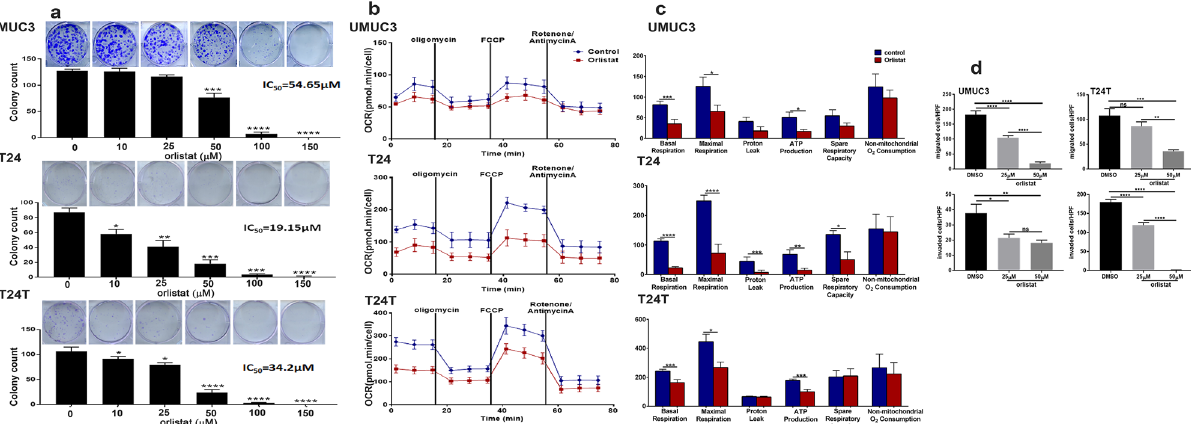
Figure 8. Effect of FASN inhibition by orlistat on BCa cells: ( a ) orlistat exerts dose-dependent inhibition of clonogenic survival of the indicated BCa cell lines. Representative images of colonies > 50 cells after treatment with orlistat. Bar graphs report mean ± SEM of colony counts/well. All experiments were performed in triplicates/experimental condition and were repeated twice. ( b ) Line tracing of the oxygen consumption rate (OCR) of BCa cells treated with 20 µM orlistat or DMSO control. ( c ) Bar graphs report mean ± SEM of indicated measurements (n = 5/experimental condition) repeated twice. ( d ) Orlistat exerts dose-dependent inhibition